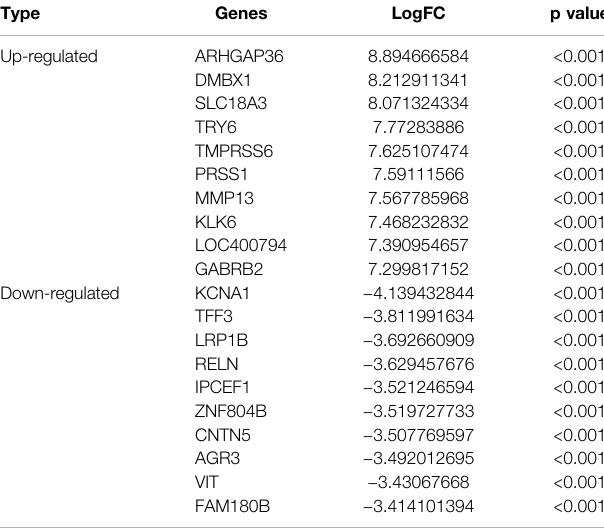
TABLE 1 | The top 10 upregulated and downregulated DE mRNA